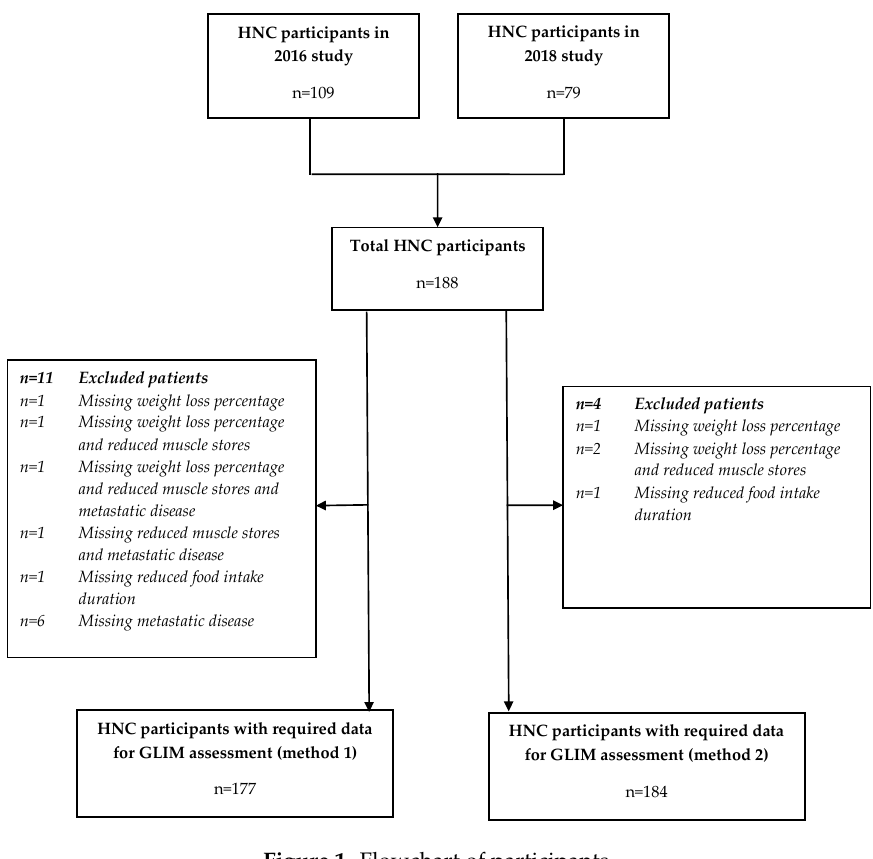
Figure 1. Flowchart of participants. Table 3. Participant characteristics ( n =